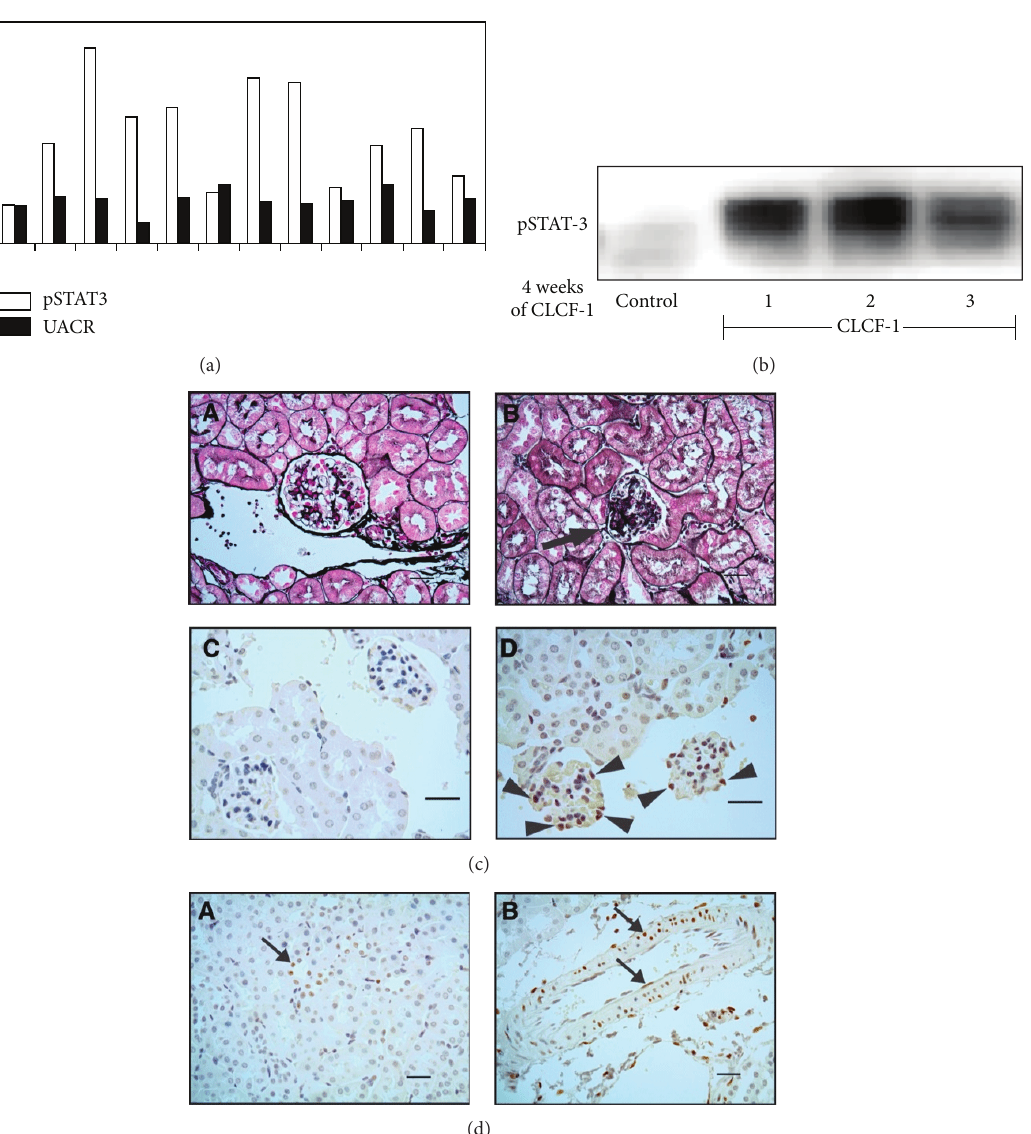
Figure 5: (a–d) Effect of acute injection or 28-day infusion of CLCF-1 on urinary albumin creatinine ratio (UACR) and renal histology and pSTAT3 expression in mice. (a) Renal cortical pSTAT3 and urine albumin creatinine (UACR) ratio 24 hours after a single injection of CLCF-1. Results for one experiment with 12 individual mice are shown as ratio of postinjection values to control values for pSTAT3 and postinjection to preinjection values for individual mice for UACR. pSTAT3 increased to 3.0 ± 1.8 (95% confidence interval 2.8 to 5.1) and UACR increased by 1.62 ± 0.37-fold versus preinjection level (95% confidence interval 1.38 to 1.85). Values are mean ± SD, 𝑁 = 12 . (b) CLCF-1 infusion increases pSTAT3 expression in renal cortex. After 4 weeks of infusion of CLCF-1 or vehicle (control) by minipump, mouse renal cortex was harvested and lysates were examined for pSTAT3 expression by Western blot. Results are shown for cortex of 3 individual mice that received CLCF-1 and one control mouse. (c) Histology of mouse renal cortex after 4 weeks of CLCF-1 or vehicle (control) infusion. Kidneys were harvested from treated and control mice, and histologic sections were prepared and stained as described in Methods and Materials. (A) Control mouse (Jones silver stain). Glomeruli showed normal cellularity and mesangial matrix without evidence of sclerosis ( > 150 glomeruli counted). Scale bar = 25 𝜇 m. (B) CLCF-1 infusion (28 days; Jones silver stain). Renal cortex after 28 days of CLCF-1 infusion. Rare glomeruli (2 in > 150 glomeruli counted) showed segmental sclerosis, with collapse of capillaries and segmental increase in matrix (arrow). Scale bar = 25 𝜇 m. (C) Anti-pSTAT3 staining of renal cortex from control treated mouse. No staining was evident. Scale bar = 25 𝜇 m. (D) Anti-pSTAT3 staining of renal cortex from mouse treated for 28 days with infusion of CLCF-1. Occasional glomerular epithelial cells showed pSTAT3 staining (arrowheads). Scale bar = 25 𝜇 m. (d) Anti-pSTAT3 staining of renal cortex from mouse treated for 28 days with infusion of CLCF-1. Focal staining of tubules (A), as well as smooth muscle and endothelial cells (B), is indicated by arrows. No staining was observed in sections of control mouse kidneys. Scale bar = 50 𝜇